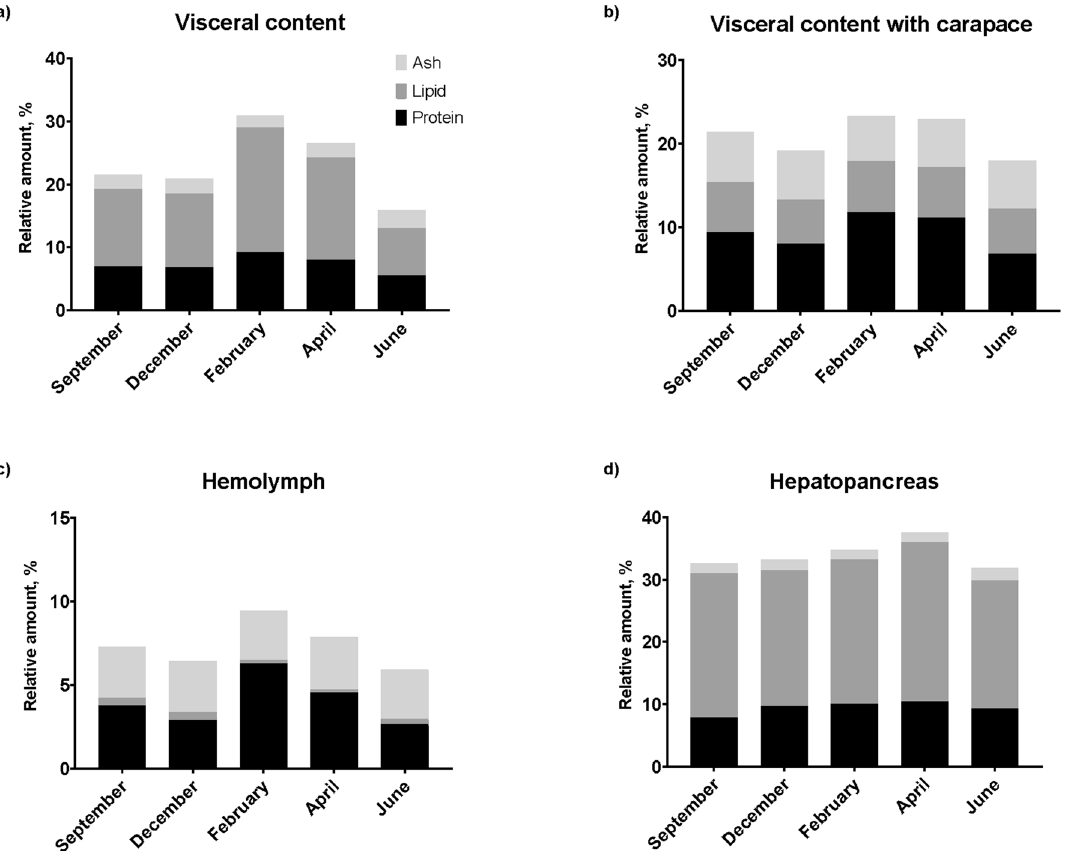
Figure 2. Biochemical parameters of co-products. Measured biochemical parameters of the co-products, i.e., Carapace and internal organs, in all months of sampling. Water, lipid, protein, and ash presented as relative amounts of each in each month of collection. Water is not depicted but is the remaining up to 100. Each bar is represented by 10 pooled and homogenized individuals of: internal organs ( a ), internal organs + carapace ( b ), hemolymph ( c ) and hepatopancreas ( d ).